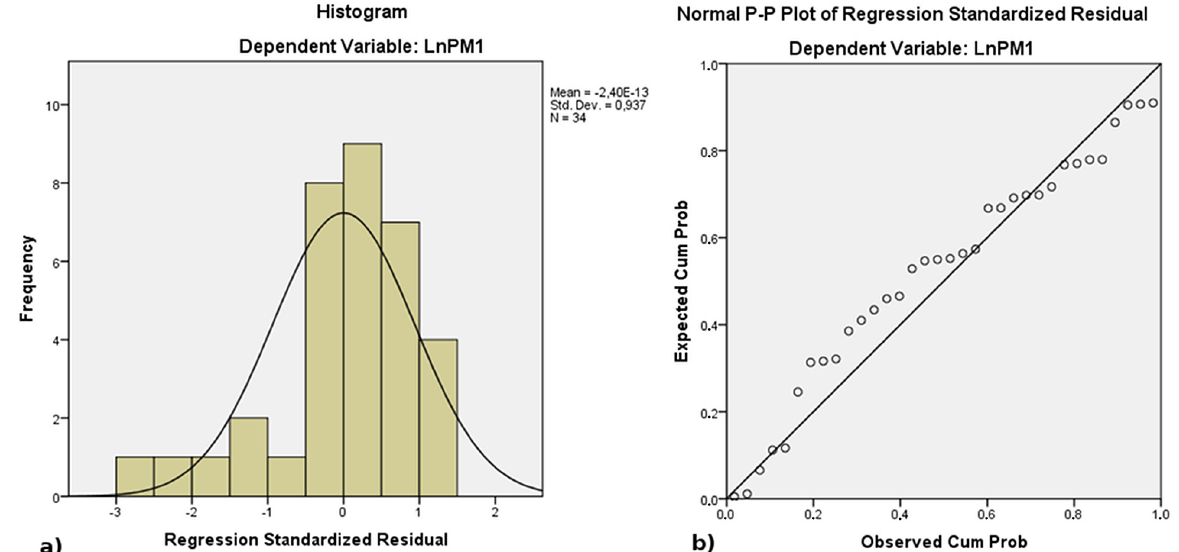
Figure 6 - a ) Histogram with normal distribution of the residuals; b ) observed and expected probabilities of the fitted ETo model for the